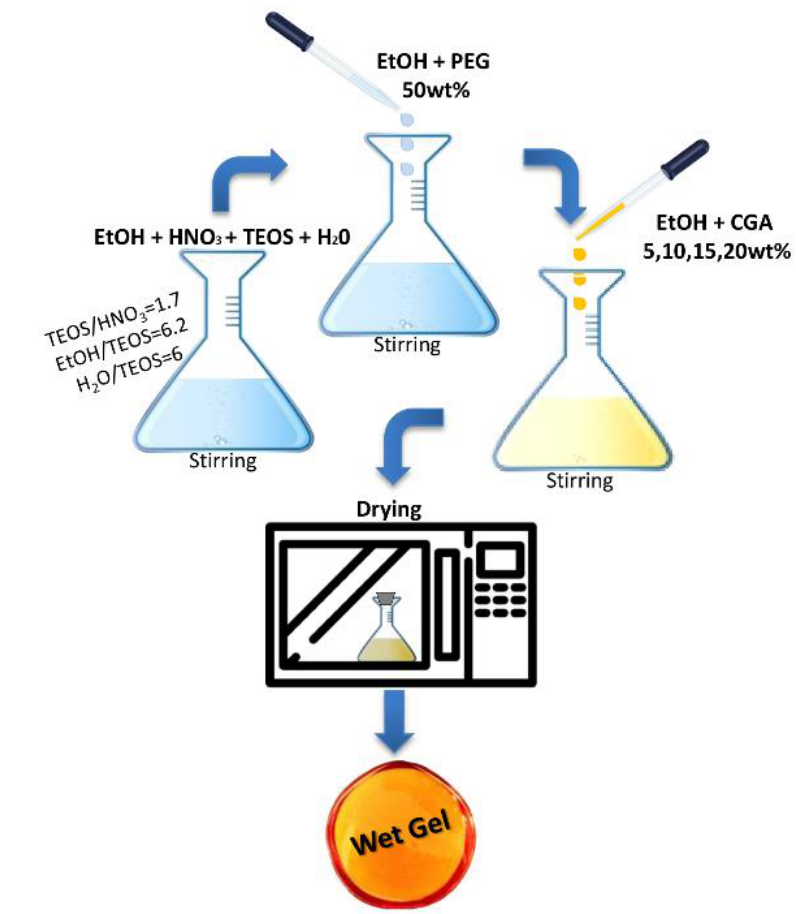
Figure 1. Flow chart of the sol-gel hybrid synthesis and the molar ratios between the reagents achieved in the sol.